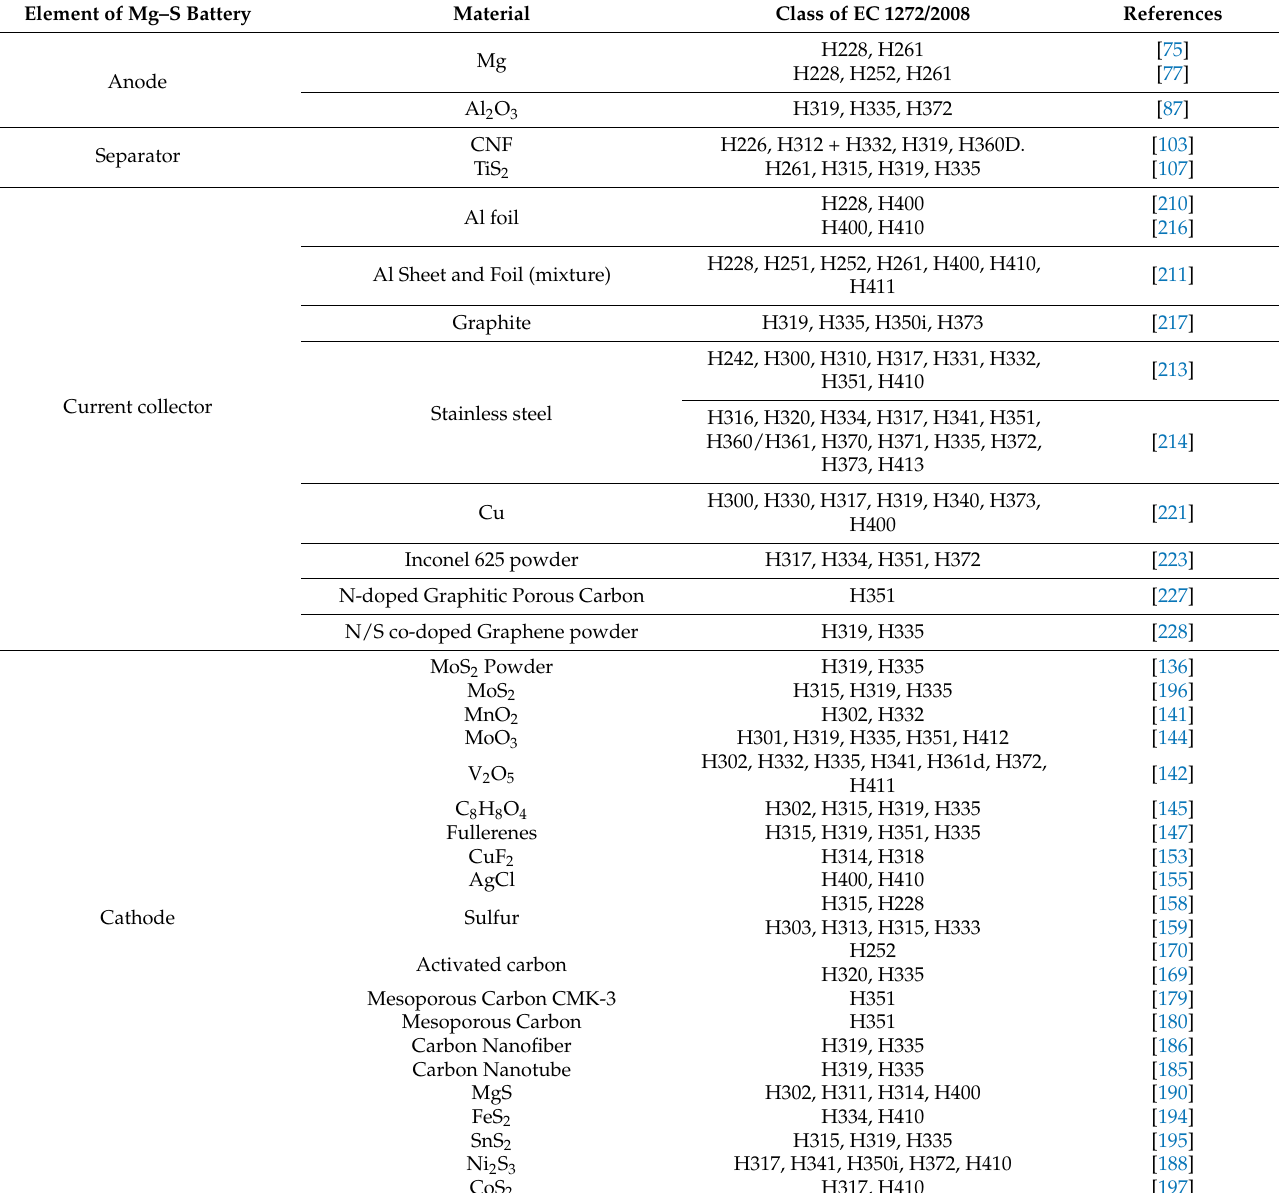
Table 2. Hazard statements related to materials utilized in Mg–S